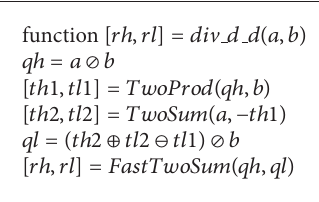
Algorithm 13: Division of a double number by a double